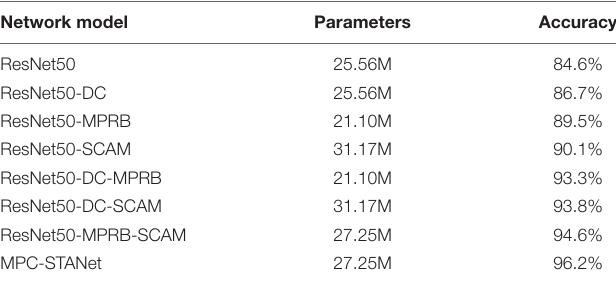
TABLE 9 | Comparison of recognition accuracy and parameters of different